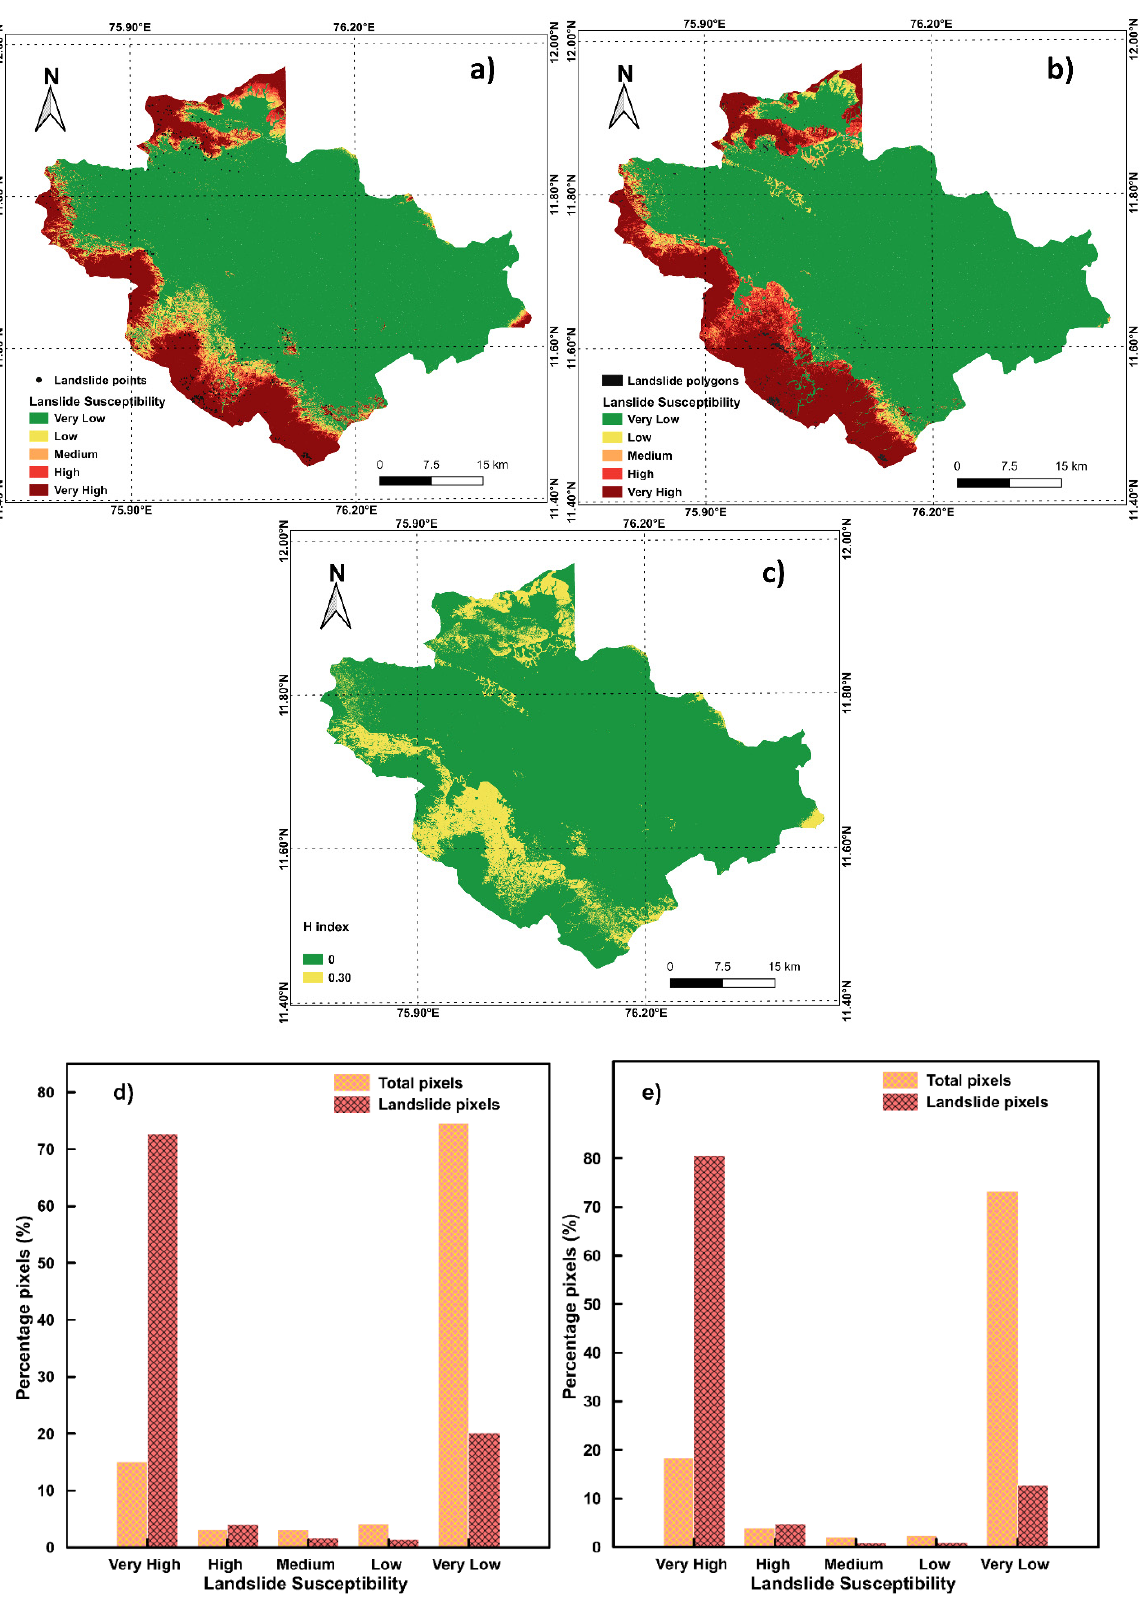
Figure 7. Details of landslide susceptibility maps prepared using NB algorithm: ( a ) using point data, ( b ) using polygon data, ( c ) H-index plot, ( d ) percentage distribution of using point data, and ( e ) percentage distribution of pixels using polygon data.